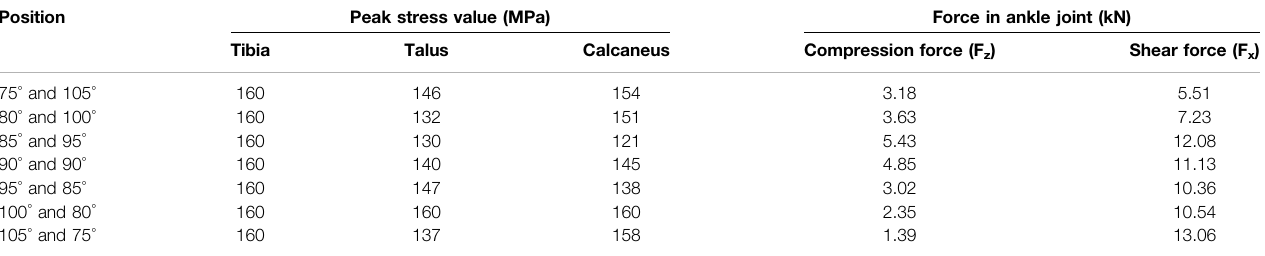
TABLE 3 | Comparison of the experiment with the simulation results. Position Peak stress value (MPa)